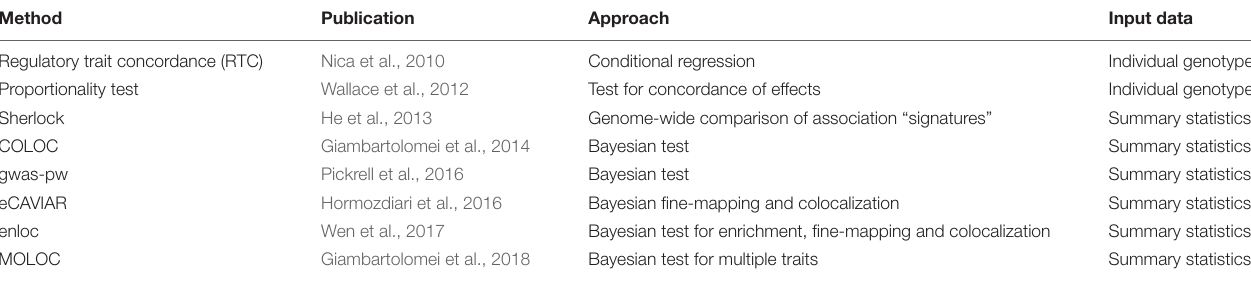
TABLE 2 | Methods for colocalization